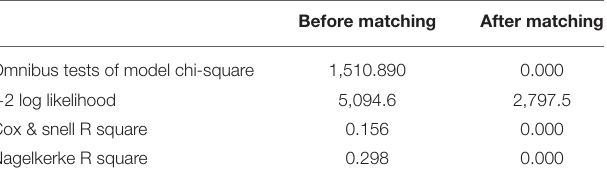
TABLE 1 | Predictive value measures of the logistic regression model before and after matching. Before matching After